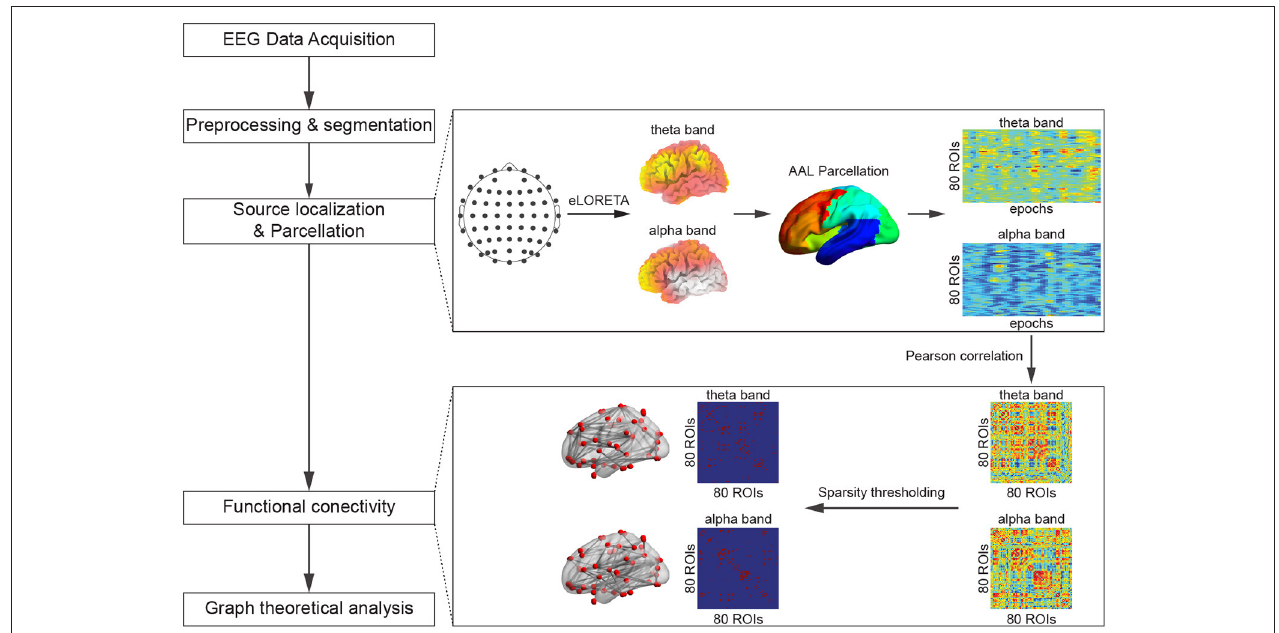
FIGURE 2 | A flowchart of the data analysis